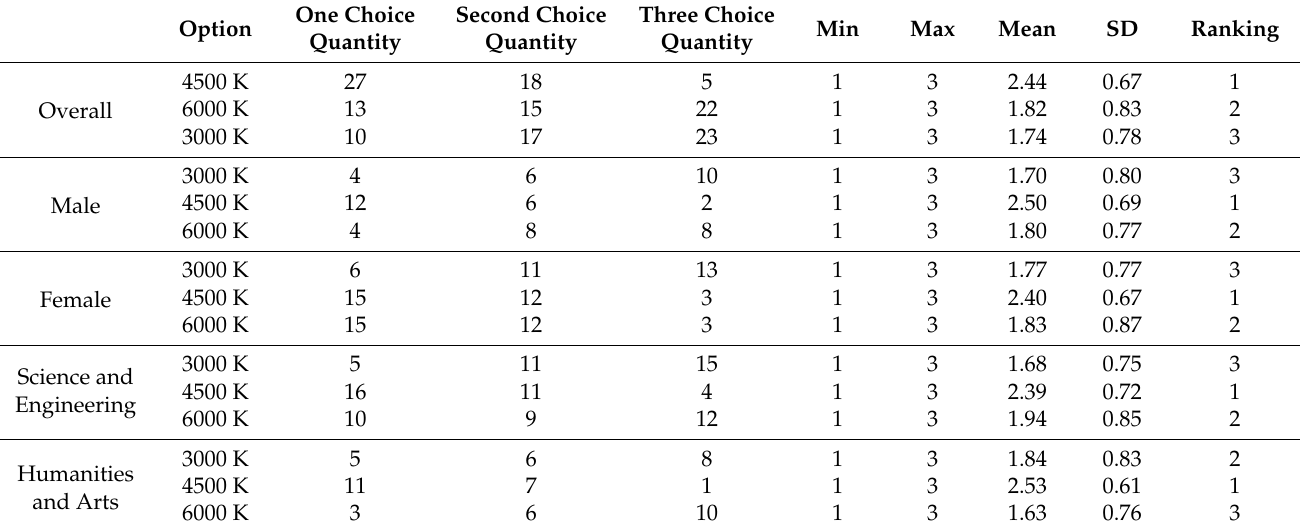
Table 5. Frequency analysis